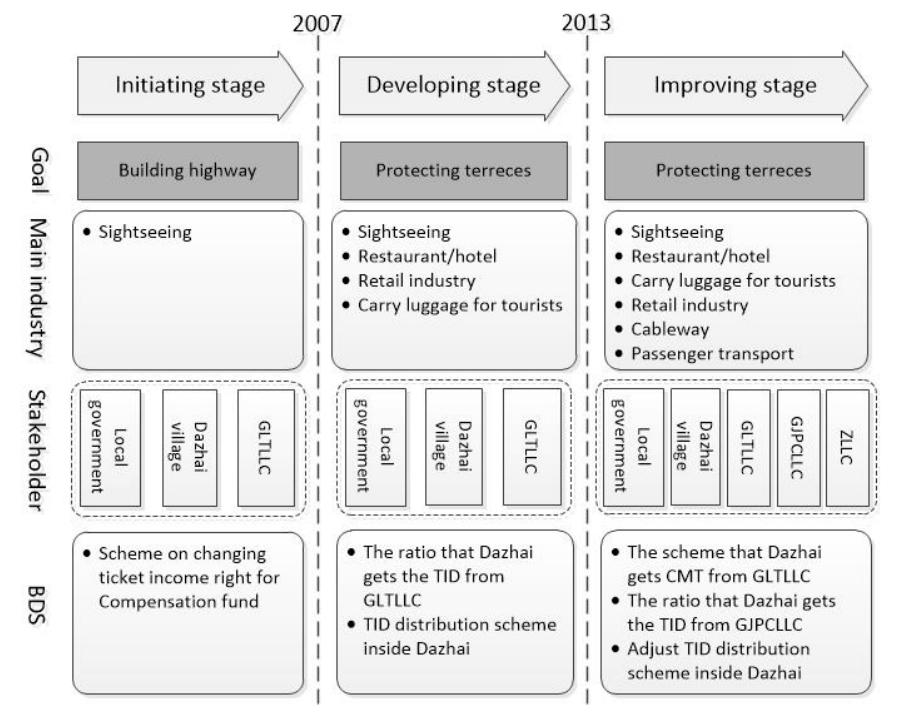
Figure 7. Evolution of Dazhai terraced tourism.